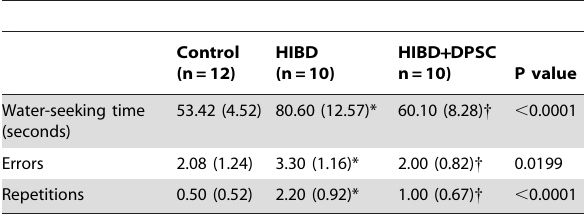
Table 1. Radial Water Maze Test Results for the 3 Groups in This Study.